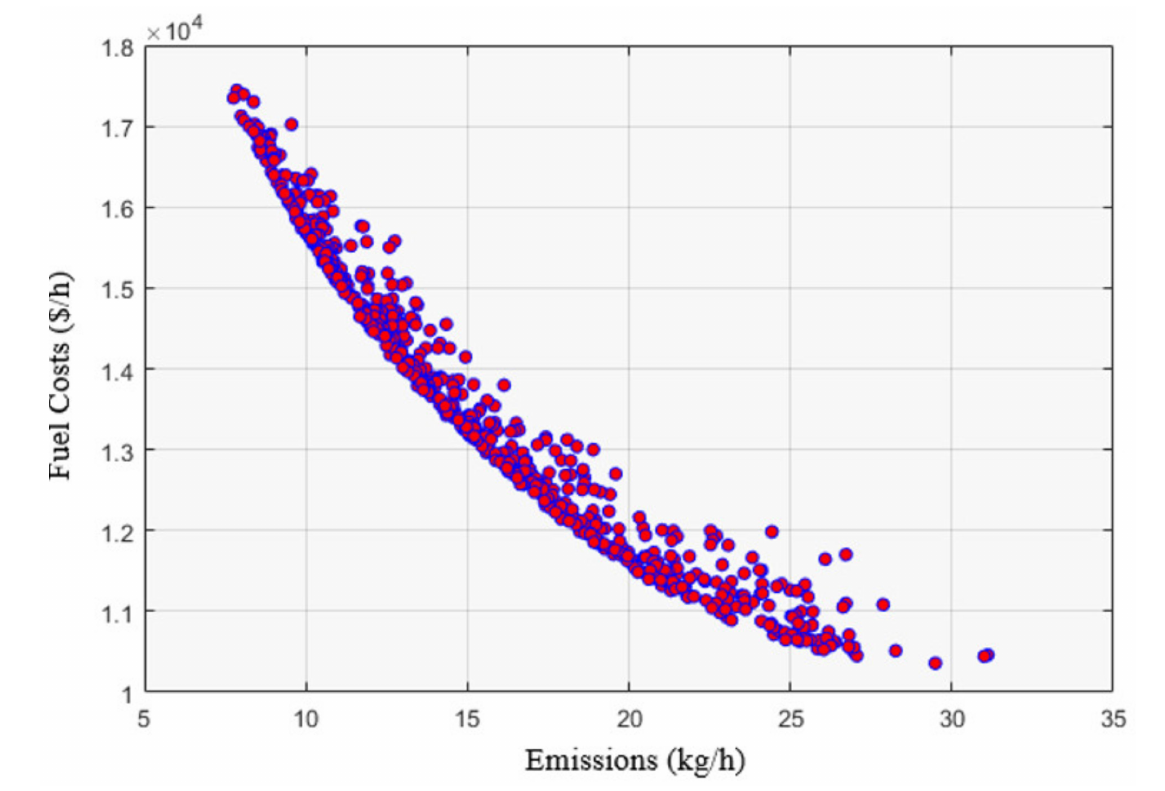
Figure 11. Development of Pareto set over the course of iterations with the MTLSBA for the CH- PEED problem.